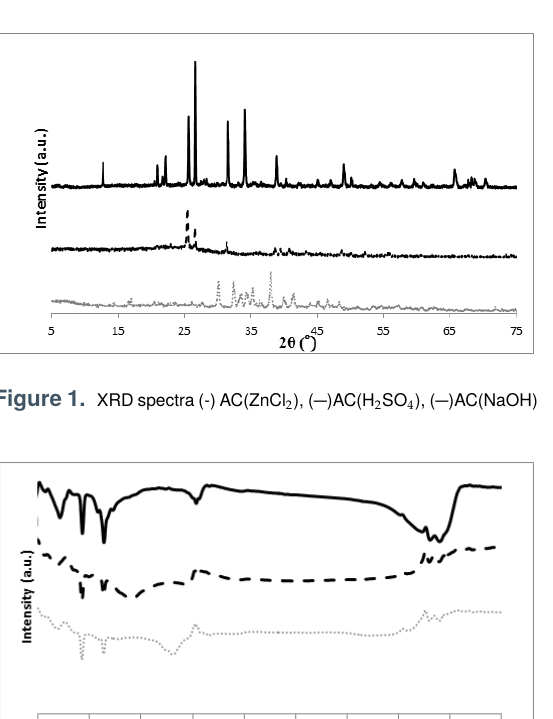
Figure 2. FT-IR spectra of AC (-) AC(ZnCl (....)AC(NaOH)